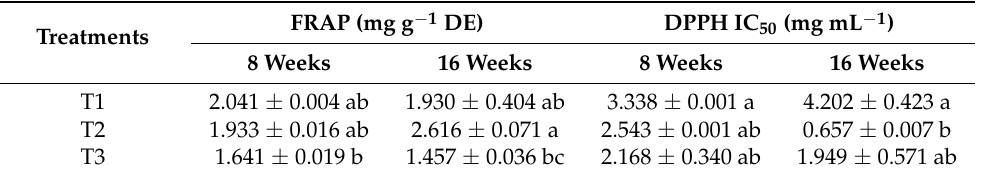
Table 3. The effects of the different shade levels on antioxidant activities of P. minus extract. (Data are means of treatments, N = 36; Rep = 3; Control, T1 = 0% Shading; T2 = 50% Shading; and, T3 = 70% Shading; DE: Dry Extract; means with different letters on top of each standard error of means are significantly different at p ≤ 0.05 between shade levels).